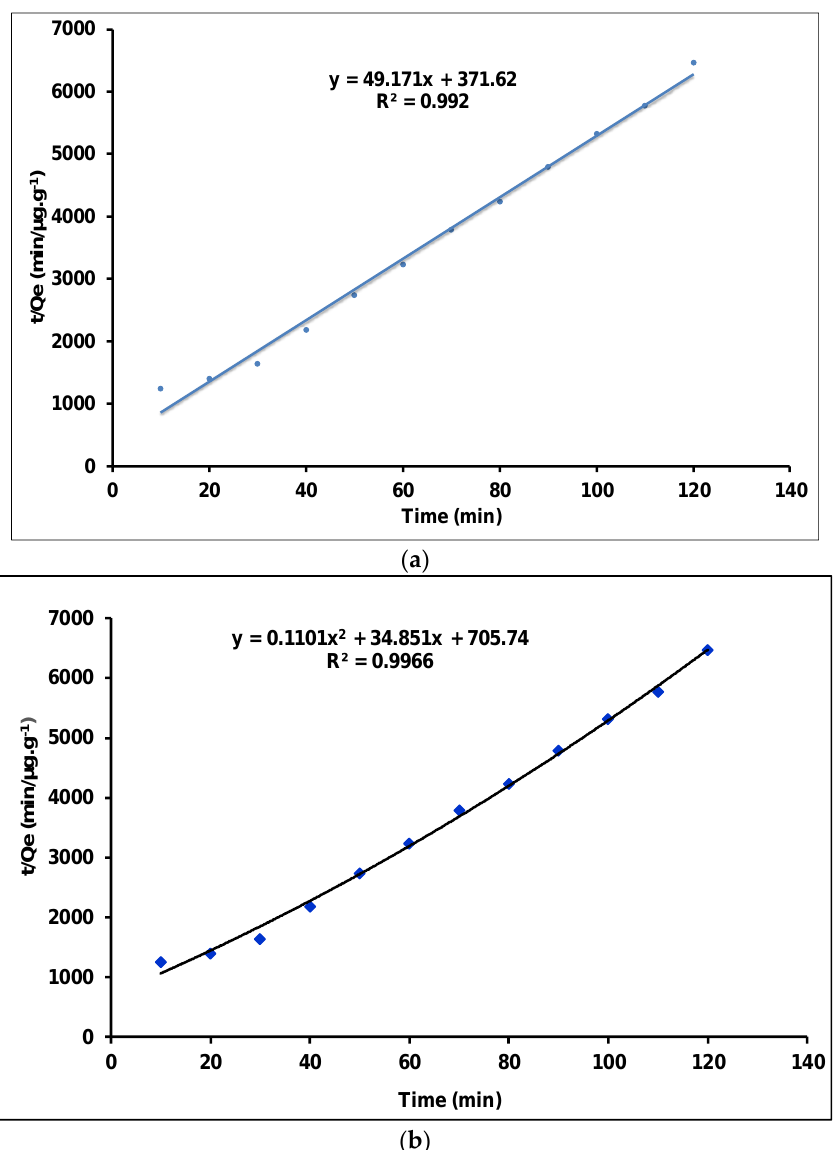
Figure 10. Pseudo-second-order model of Tl(I) adsorption on the γANPs: ( a ) linear model and ( b ) quadratic model.